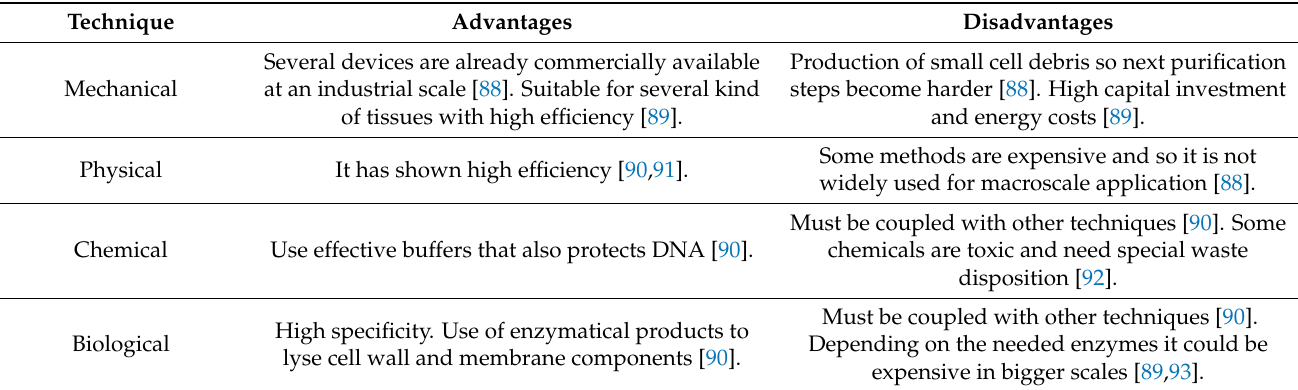
Table 3. Comparative characteristics of cell lysis